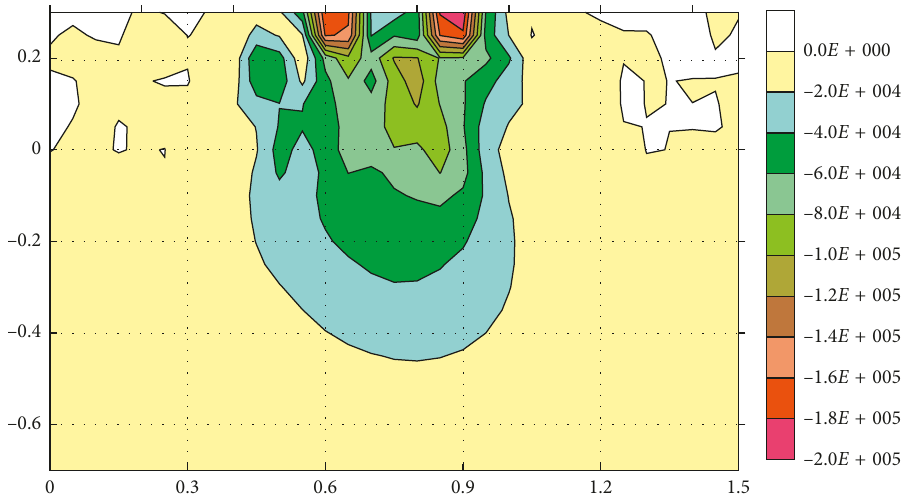
Figure 8: Stress contour of the model.